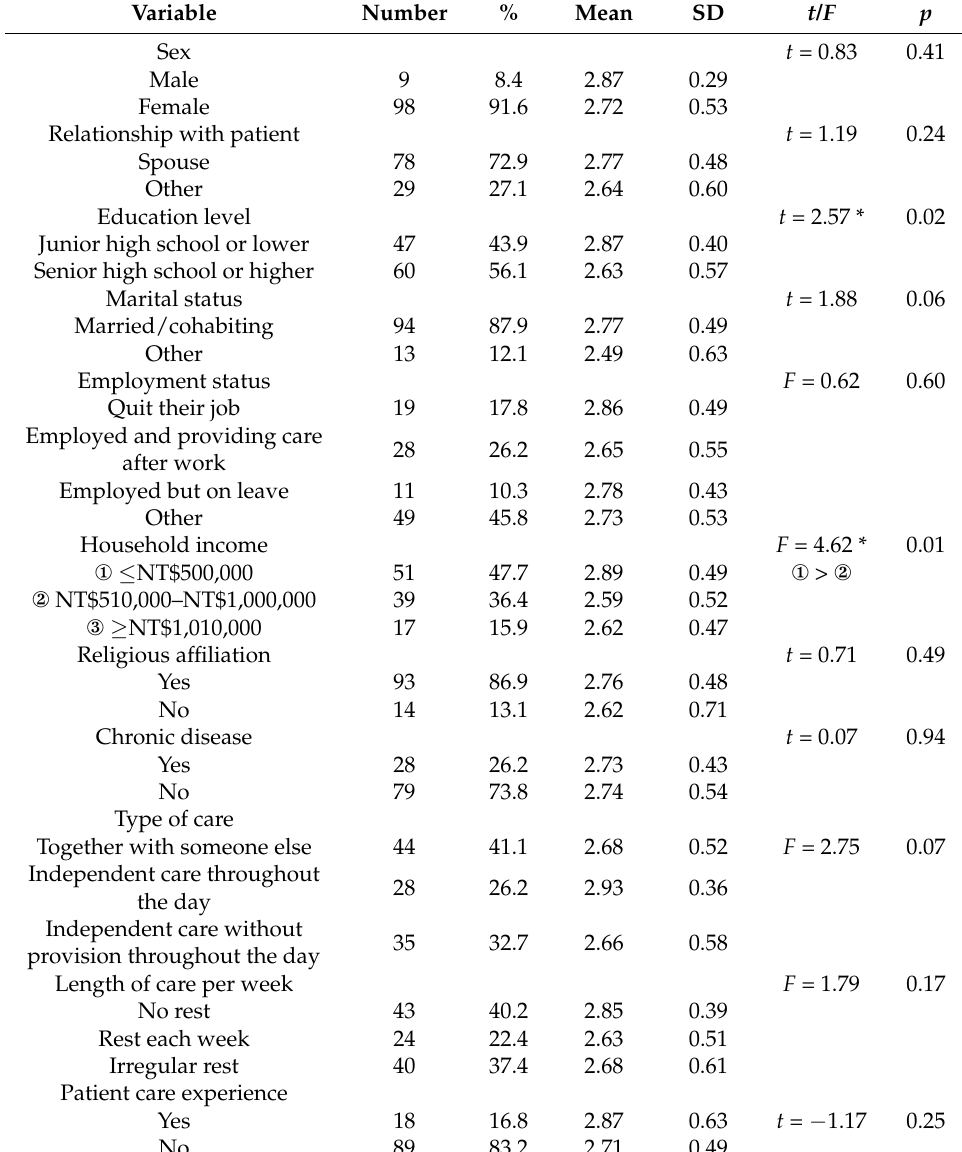
Table 1. Differences in total burden of the primary family caregivers according to their sociodemo- graphic variables and the type of care ( n =